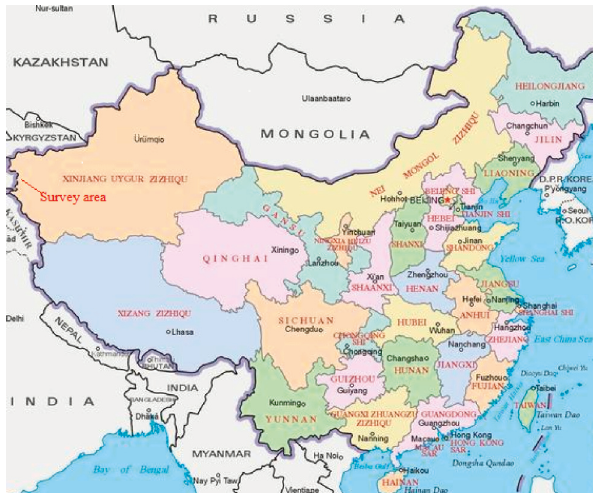
Figure 2: The location of survey